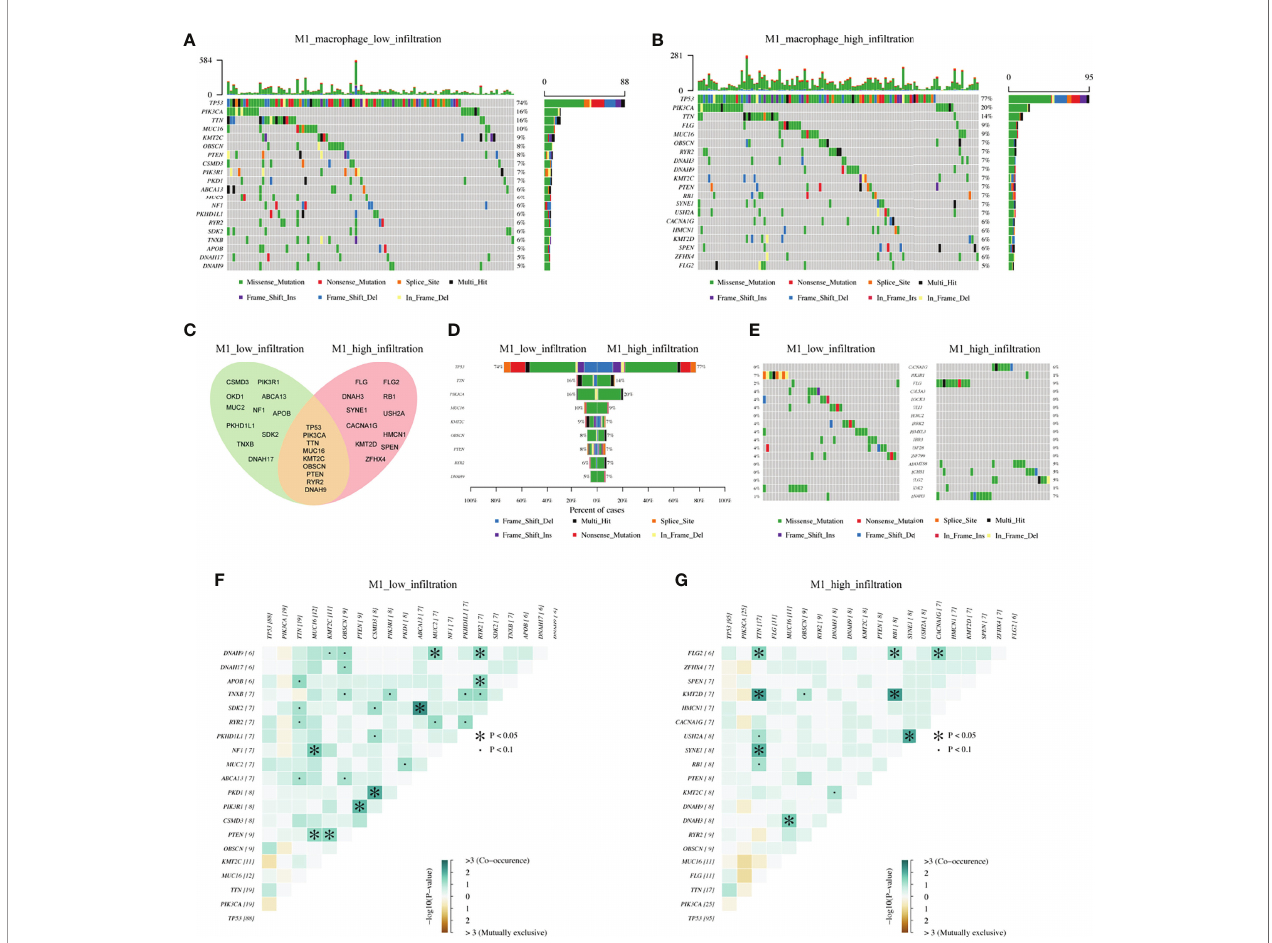
FIGURE 4 | The differentiation of mutational landscape between low and high M1 macrophage in fi ltration groups from FUSCC cohort. (A, B) Top20 mutational genes in M1 macrophage low and high in fi ltration population. (C, D) The overlap of mutations in two groups. (E) Different mutations between two groups. (F, G) Mutually exclusive or co-occurring mutation in two groups were explored